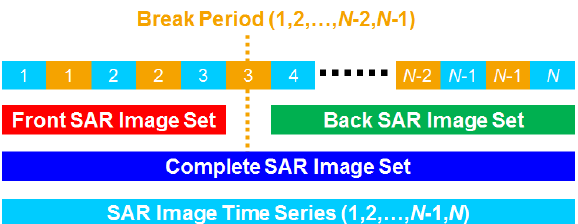
Figure 1. Three sets of SAR image time series. Complete SAR image set covers entire SAR images. Front and back SAR image sets comprise images before and after the break period